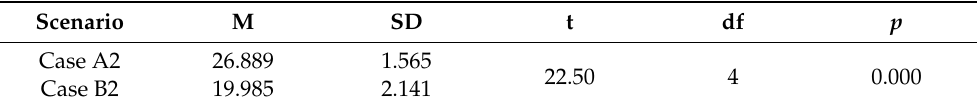
Table 14. Results of the paired sample t -test for scenario 2.